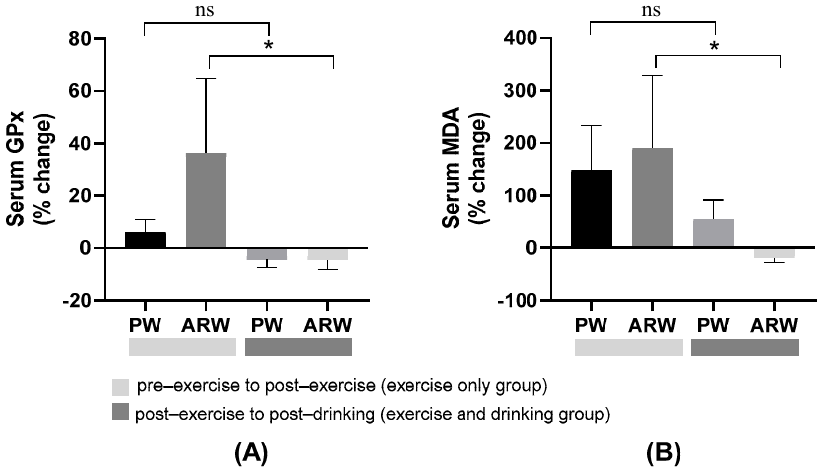
Figure 3. Effects of ARW consumption on GPx and MDA levels of healthy individuals after intense exercise. Blood was collected from the participants pre- and post-exercise. Participants consumed PW or ARW after exercise and blood was collected. Fold changes in the serum levels of GPx ( A ) and MDA ( B ) were calculated pre- to post-exercise and post-exercise to post-drinking. Statistical significance was analyzed via a one-way ANOVA (Mann–Whitney U test). * p < 0.05. Abbreviations: GPx, glutathione peroxidase; MDA, malondialdehyde; ns, not significant; PW, purified water-drinking group; ARW, alkaline reduced water-drinking group.